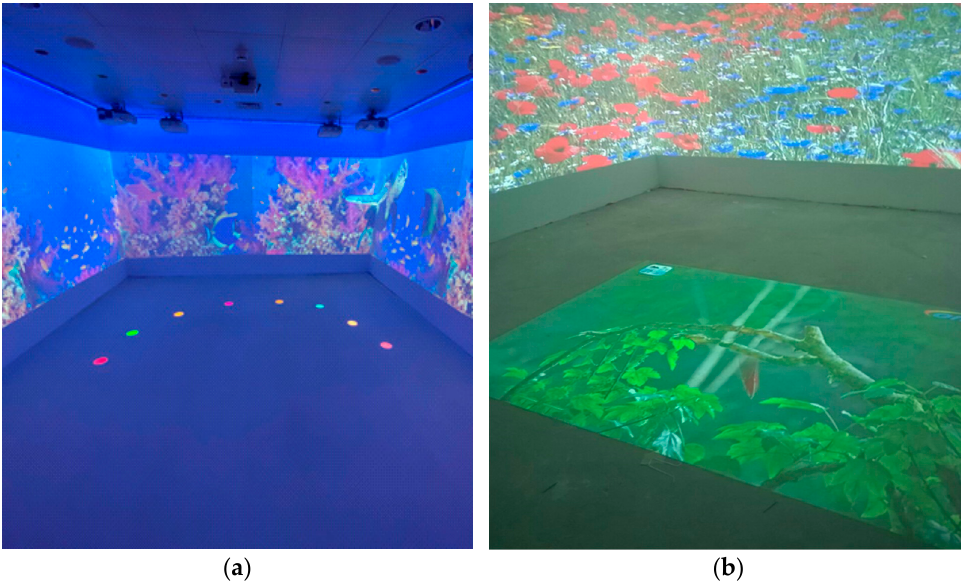
Figure 2. ( a ) Interior of the Multisensory Interactive Room, eight light beams projected on the floor. ( b ) Interior of the Multisensory Interactive Room, interactive area on the floor.